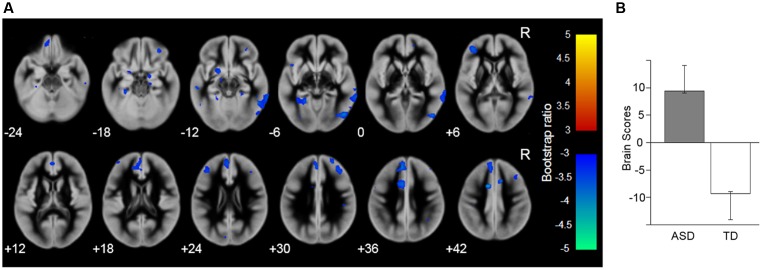
Brain network showing the latent variable that significantly discriminated the autism spectrum disorder (ASD) and typically developing (TD) groups. (A) Latent variable maps. The blue–cyan color indicates the reduced gray matter volume in the ASD compared with the TD group; the red–yellow color indicates the opposite direction. The areas are overlaid on the template gray matter image. Numbers below the slices indicate the z-axis of the Montreal Neurological Institute system coordinates. R, right hemisphere. (B) The mean (with the upper and lower 95% confidence limits) brain scores of the latent variable (i.e., the degree to which the pattern of gray matter volume across the whole brain, identified by the latent variable, is expressed in each participant).